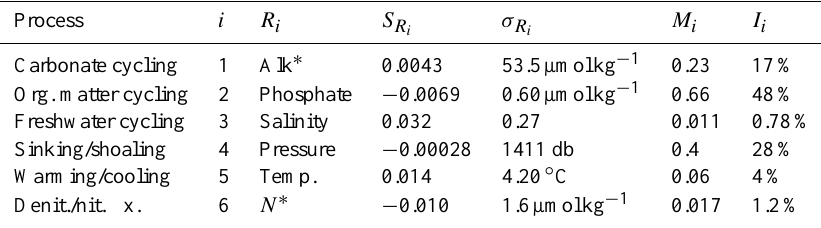
Table 1. Metric estimates M i , relative process importance percentages I i , calcite saturation sensitivities S R reference properties, and reference property standard deviations σ R all ocean depths. We provide details on how these terms are estimated and M i and I i uncertainties are obtained.